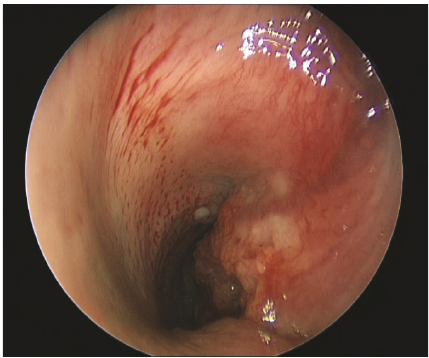
Figure 3: Tracheoscopy showing invasion of trachea from thyroid